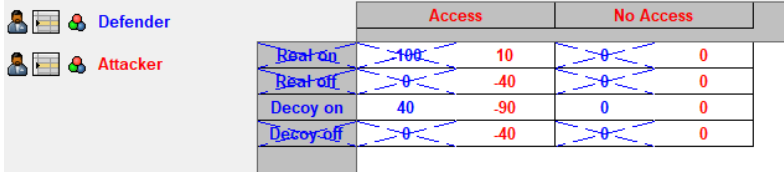
Figure 3. Results of the dominance for N 1